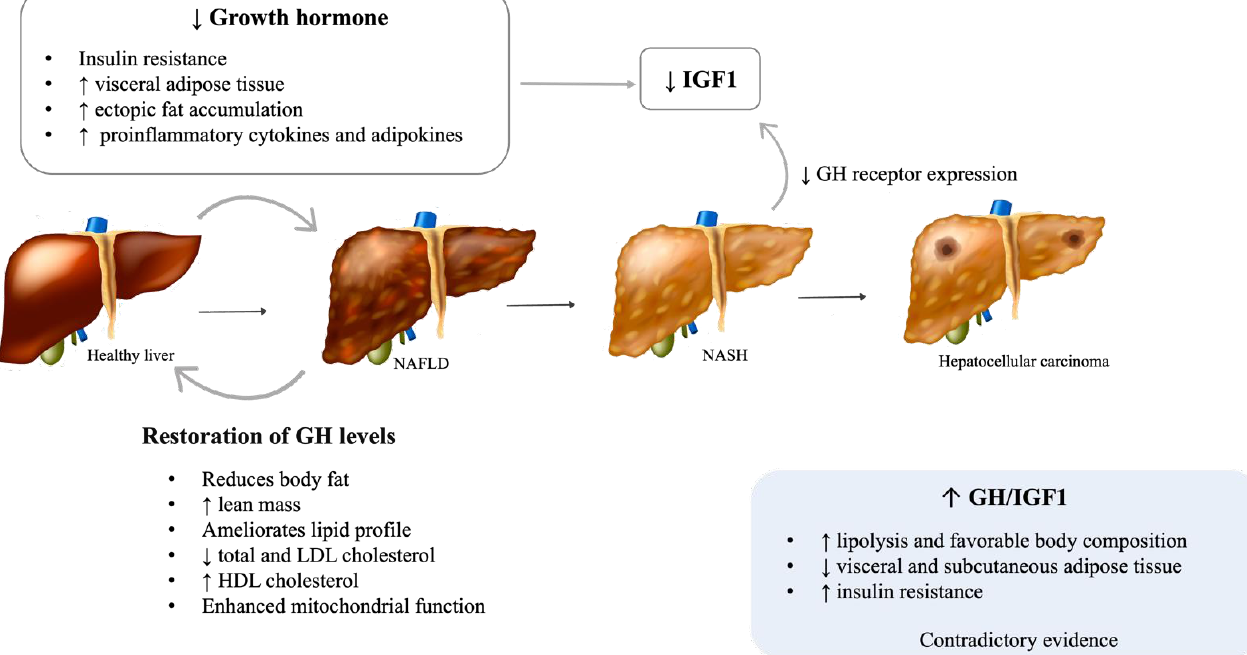
Figure 1. Possible mechanisms of GH deficiency on NALFD development and progression. NAFLD: Nonalcoholic fatty liver disease; NASH: Nonalcoholic steatohepatitis; GH: Growth hormone; IGF1: Insulin-like growth factor 1. [Viktoriia Kasyanyuk] © 123RF.com (accessed on 22 February 2022) and Servier Medical Art by Servier.